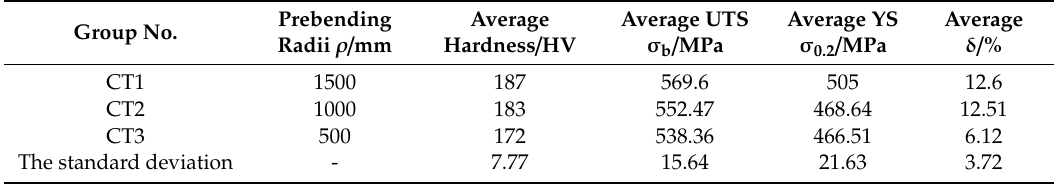
Table 2. Mechanical properties of 7075 aluminum alloy at di ff erent preloading radii. Group